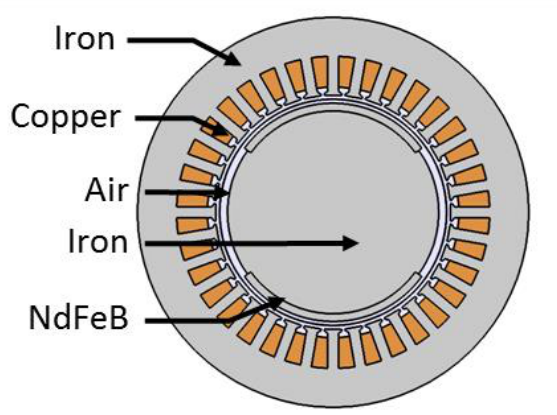
Fig. 4. PMSM model,